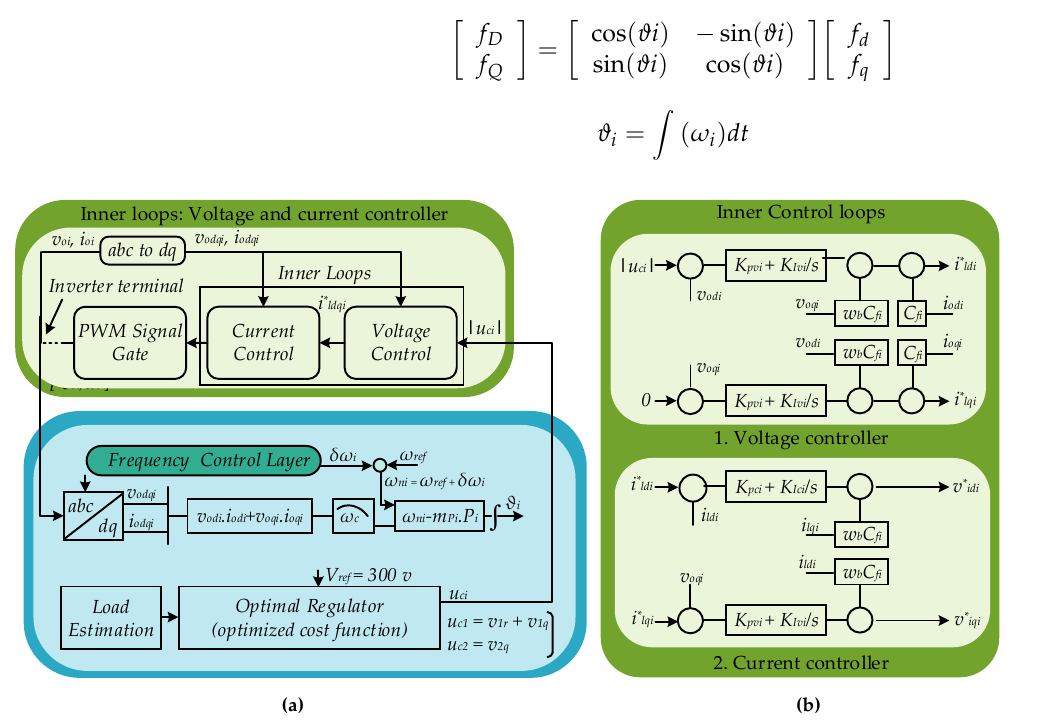
Figure 5. ( a ) Power controller of ith inverter. ( b ) Inner control loops: voltage and current controller.